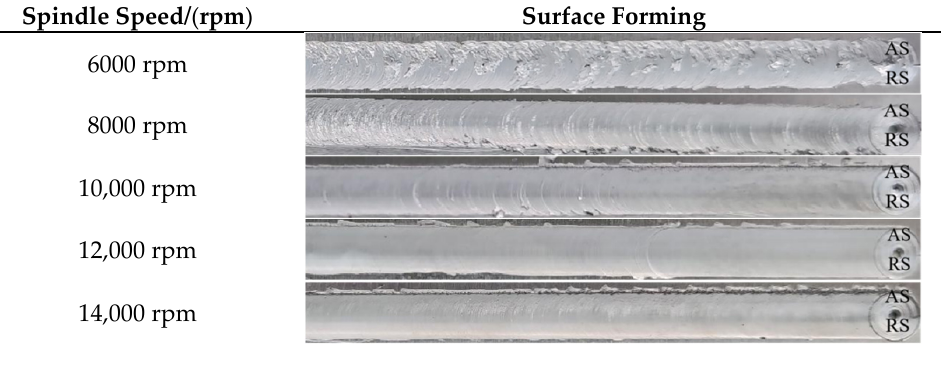
Figure 4. Surface forming of high-speed micro friction-stir weld of the ultrathin plate under different spindle speeds.